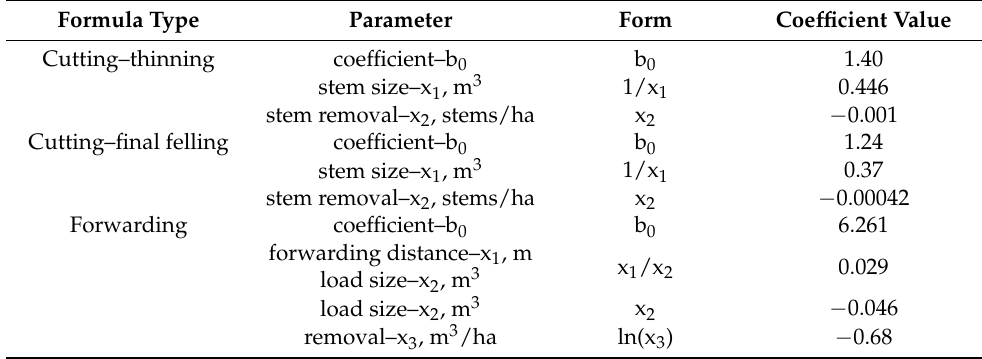
Table 2. Time consumption functions (min/m 3 ) for the productive machine time (PMH, E 0 ) for cutting and forwarding in the simulation model.